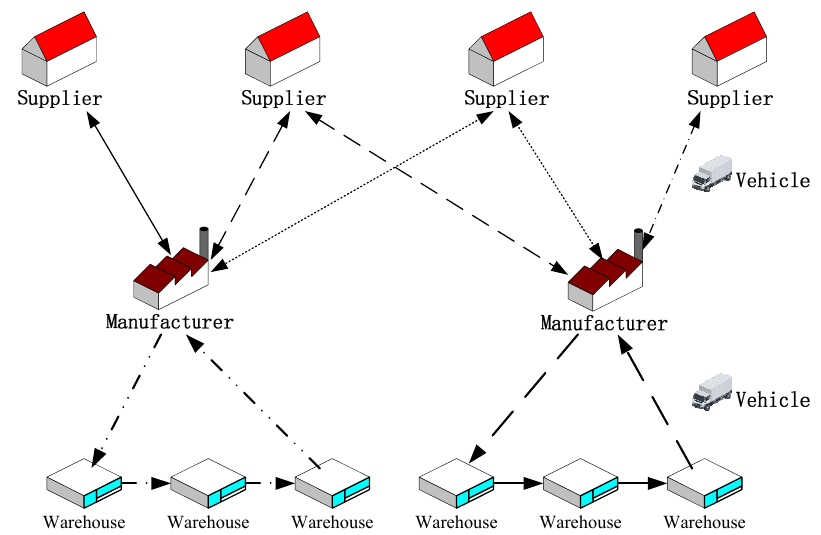
Figure 1. The distribution schematic diagram of